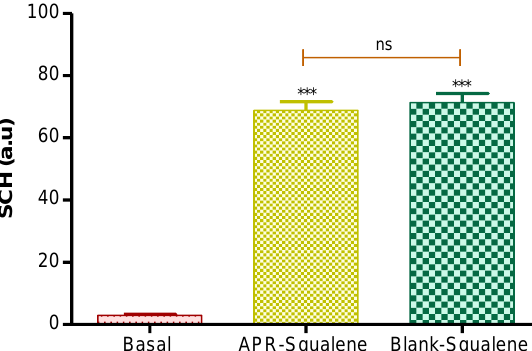
Figure 5. Stratum corneum hydration. p value: *** = p < 0.0001; ns = no significance.